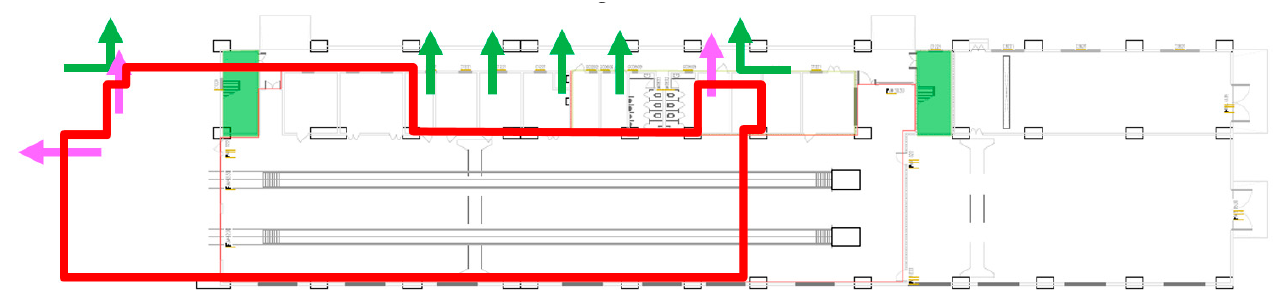
Figure 5. Schematic diagram of the evacuation path in an engineering garage.